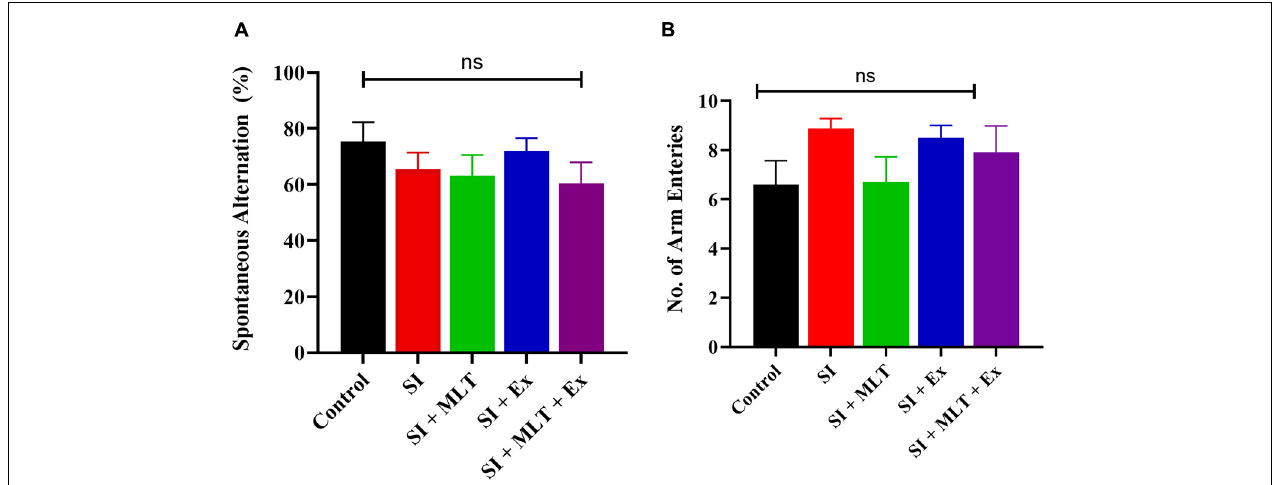
FIGURE 7 | The effect of MLT and Ex on spontaneous alternation (%) (A) , and frequency of arm entries (B) among groups in the Y maze. Data are presented as the mean ± SEM. One-way ANOVA was used. ns, non-significant.